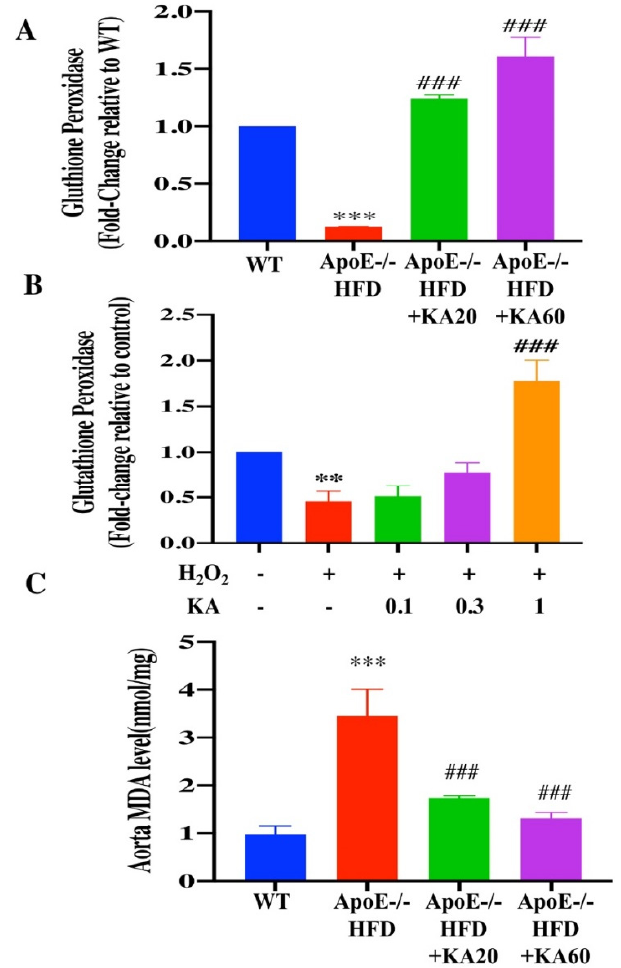
Figure 6. Effects of Kansuinine A (KA) on glutathione peroxidase (GPx) activity in vivo or in vitro and the aorta MDA level in mice. Activity of GPx was measured in ( A ) aortic tissue homogenates from mice in the different groups and ( B ) human aortic endothelial cells exposed to KA (0.1, 0.3, and 1.0 µ M) for 1 h before H 2 O 2 (200 µ M) treatment for 24 h. Data are presented as the means ± standard deviations (n = 5). p Values were determined using the Student’s t -test. ** p < 0.01, *** p < 0.001 vs. WT or control group; ### p < 0.001 vs. ApoE − / − mice fed a high-fat diet (HFD) or cells from the H 2 O 2 group. ( C ) MDA levels in aorta of mice. ApoE − / − mice fed an HFD or maintained on an HFD supplemented with 20 or 60 µ g/kg KA per g of body weight three times a week for 15 weeks. Data are presented as the means ± standard deviations (n = 5). p Values were determined using the Student’s t -test. *** p < 0.001 vs. ApoE − / −